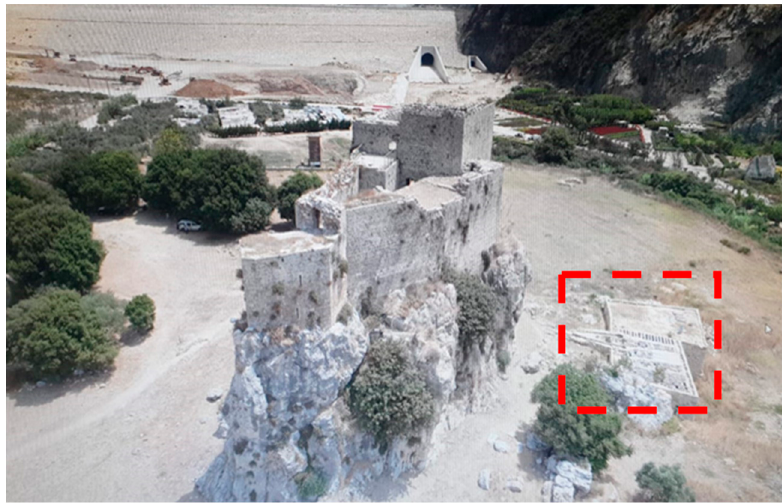
Figure 2. Mseilha Fort showing the mill to the right of the castle in